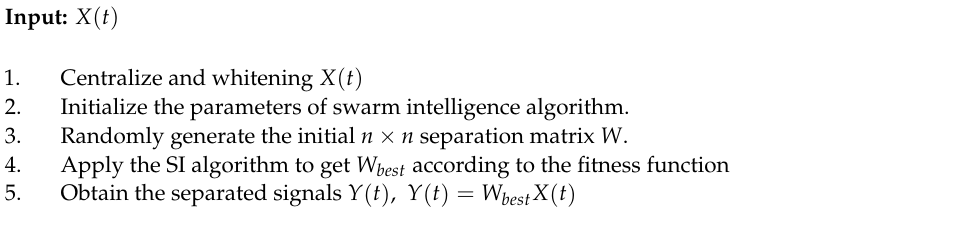
Algorithm 1 : SI-BSS (Blind Source Separation Based on Swarm Intelligence Algorithm)